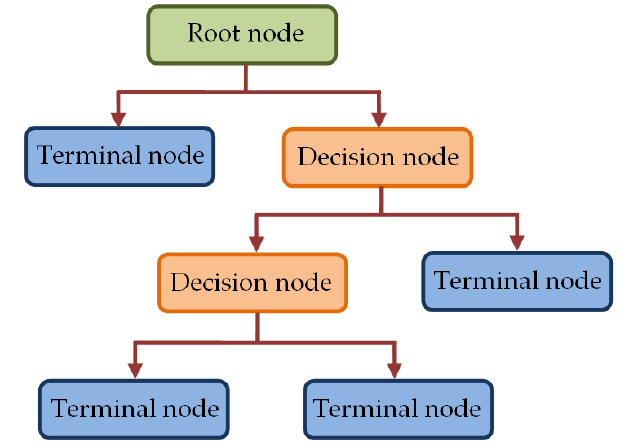
Figure 7. The tree structure in DT classifier.